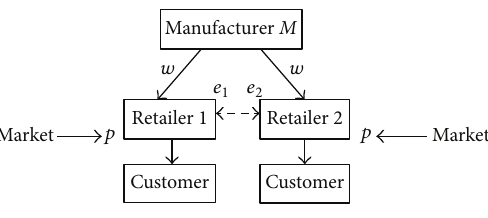
Figure 1: Multiagent channel